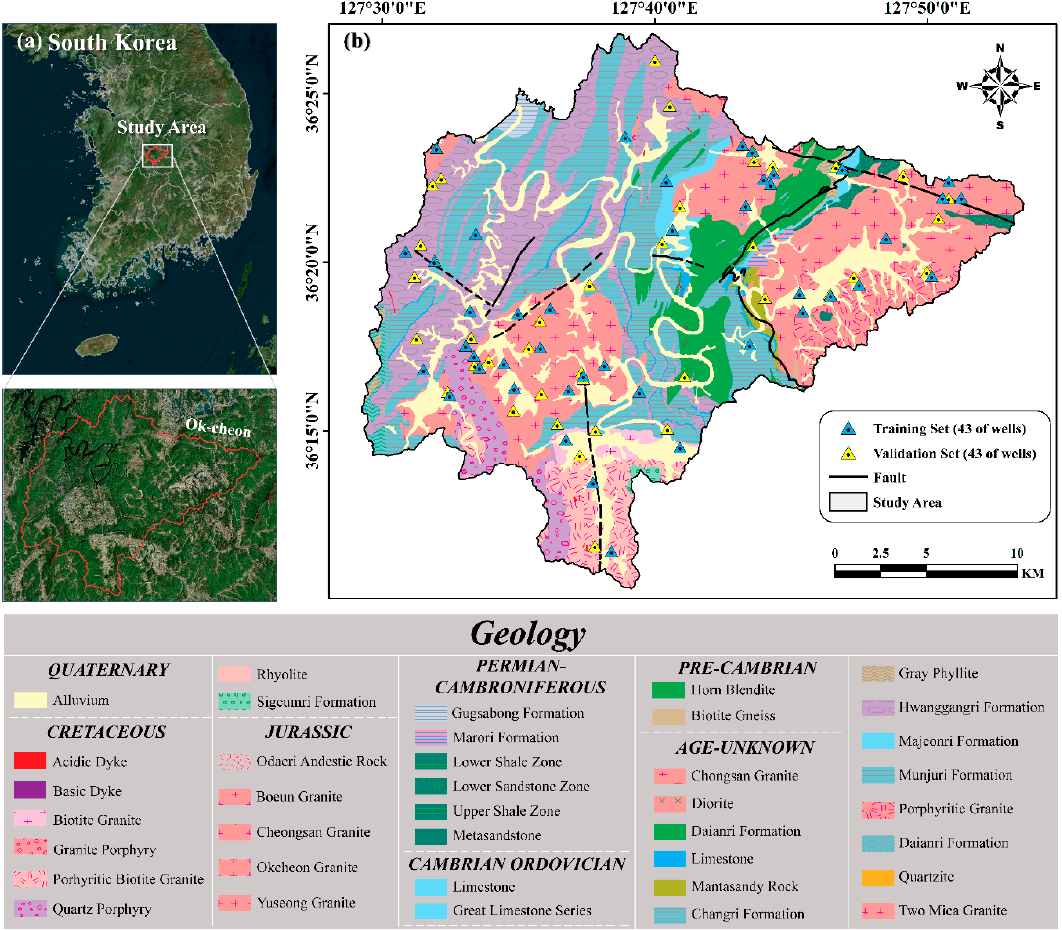
Figure 1. Study area ( a ) and geological map ( b ).